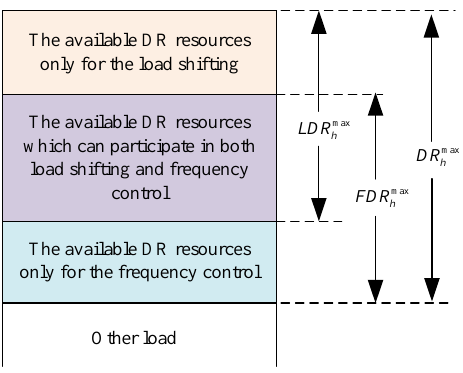
Figure 1. The available demand response (DR) resources in the considered problem.